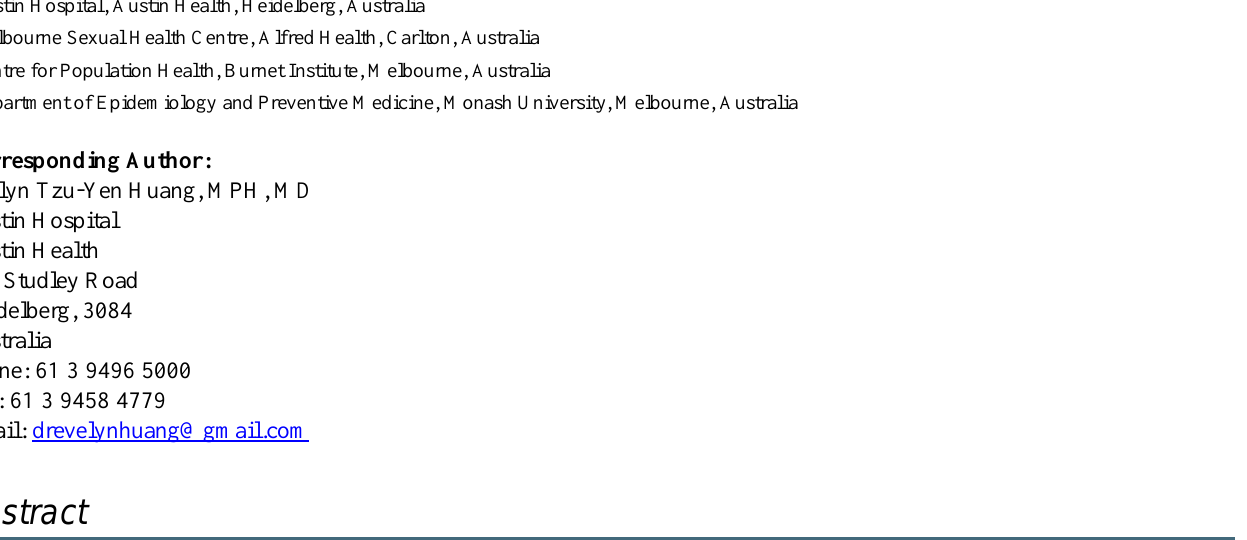
mobile apps; sexual health; STDs; sexually transmitted diseases; mobile health;